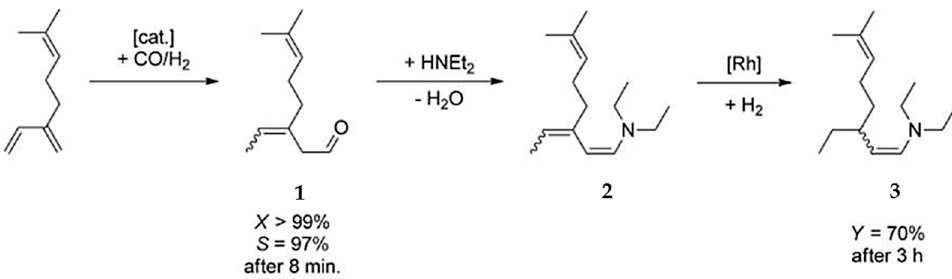
Figure 15. Hydroaminomethylation of myrcene. GC based yields (Y) and conversions (X) are given in % of reacted myrcene. Reproduced from [78] with permission from Willey.